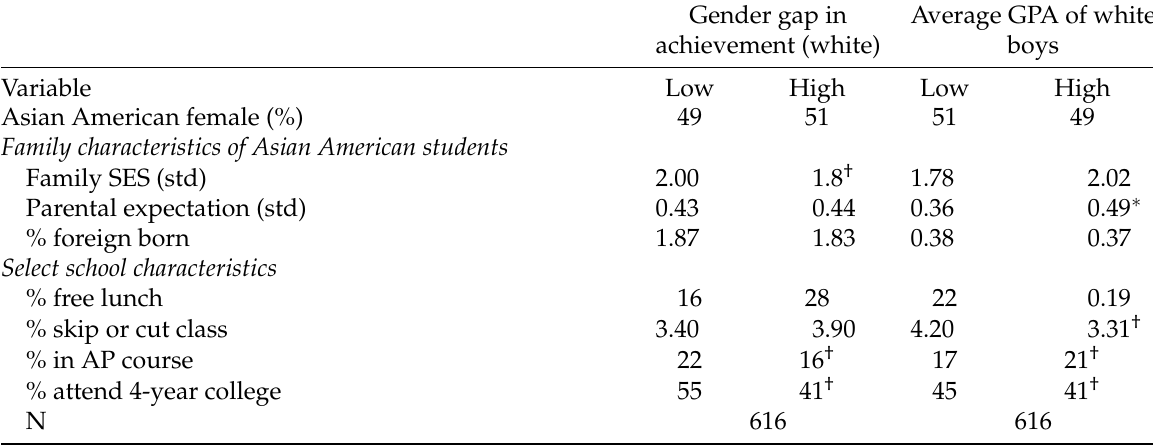
Table 2: Select descriptive statistics by school environment, 11th-grade